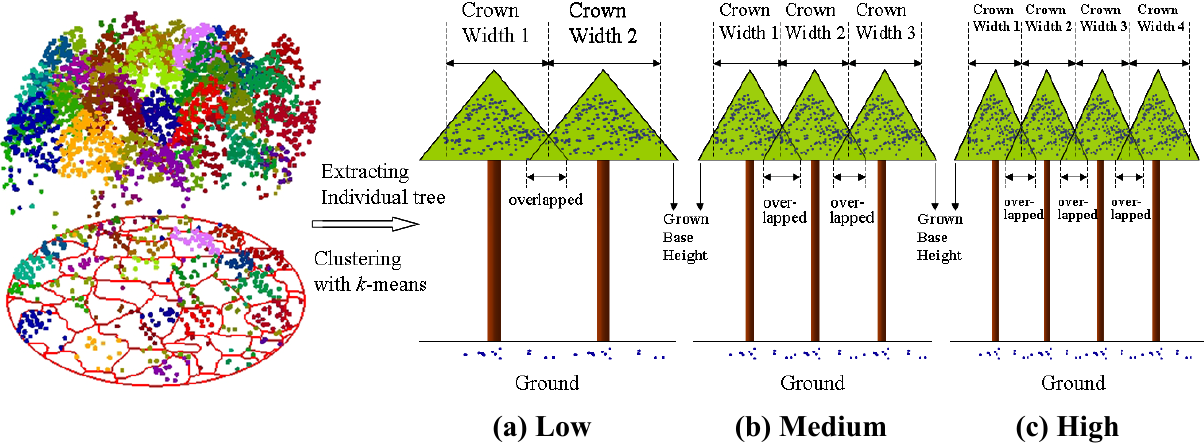
Figure 11. Relationship between overlapping effect level and low (a) , medium (b) , and high (c) tree